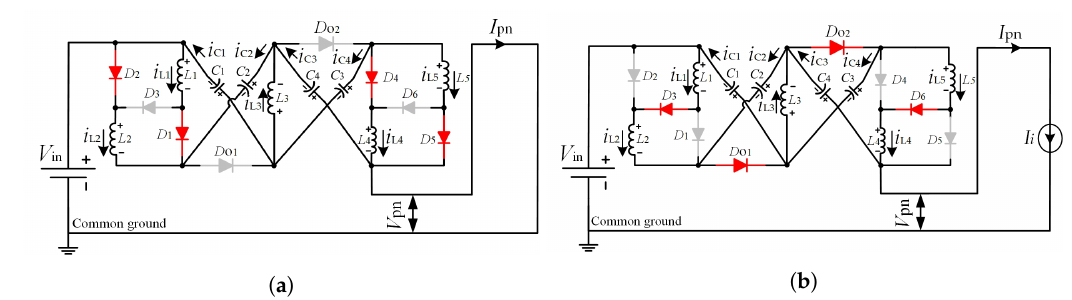
Figure 1. Proposed inverter (SL-SBZSI).